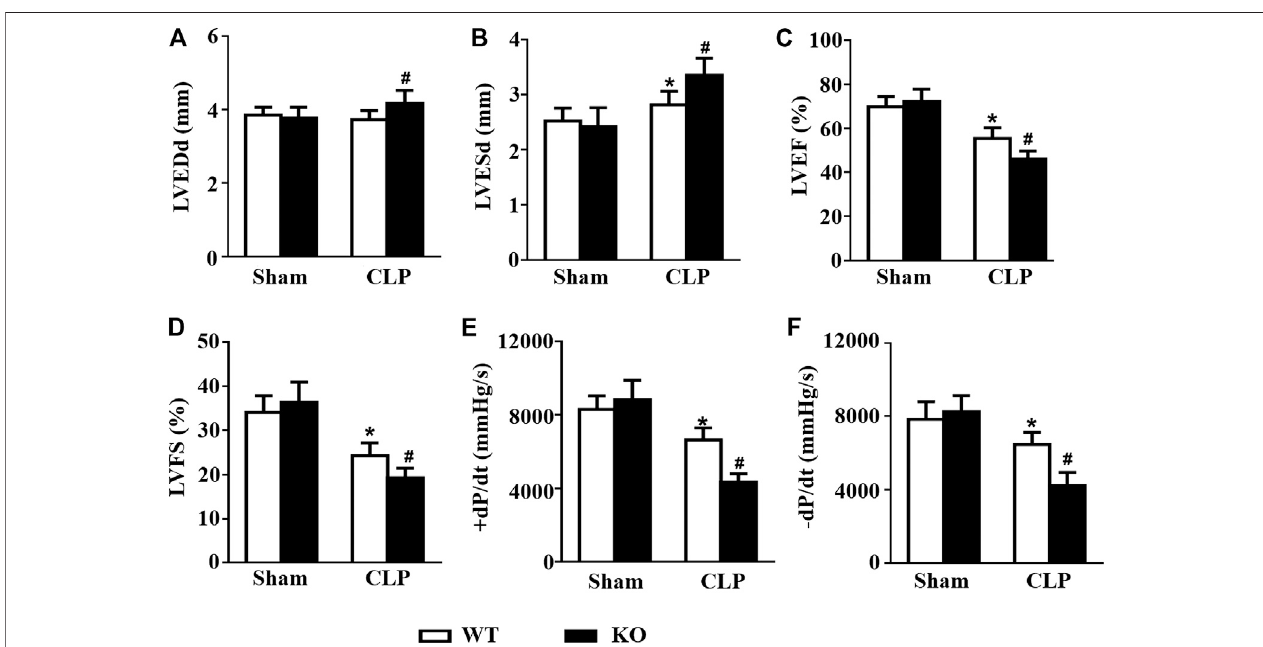
FIGURE 9 | Il12a deletion exacerbates CLP-induced cardiac dysfunction. (A – D) Echocardiographic analysis of LVEDd, LVESd, LVEF and LVFS in each group (n (cid:1) 8). (D,E) Hemodynamic analysis of +dP/dt and -dP/dt in each group (n (cid:1) 6). * p < 0.05 compared with the sham + WT group; # p < 0.05 compared with the CLP + WT group.